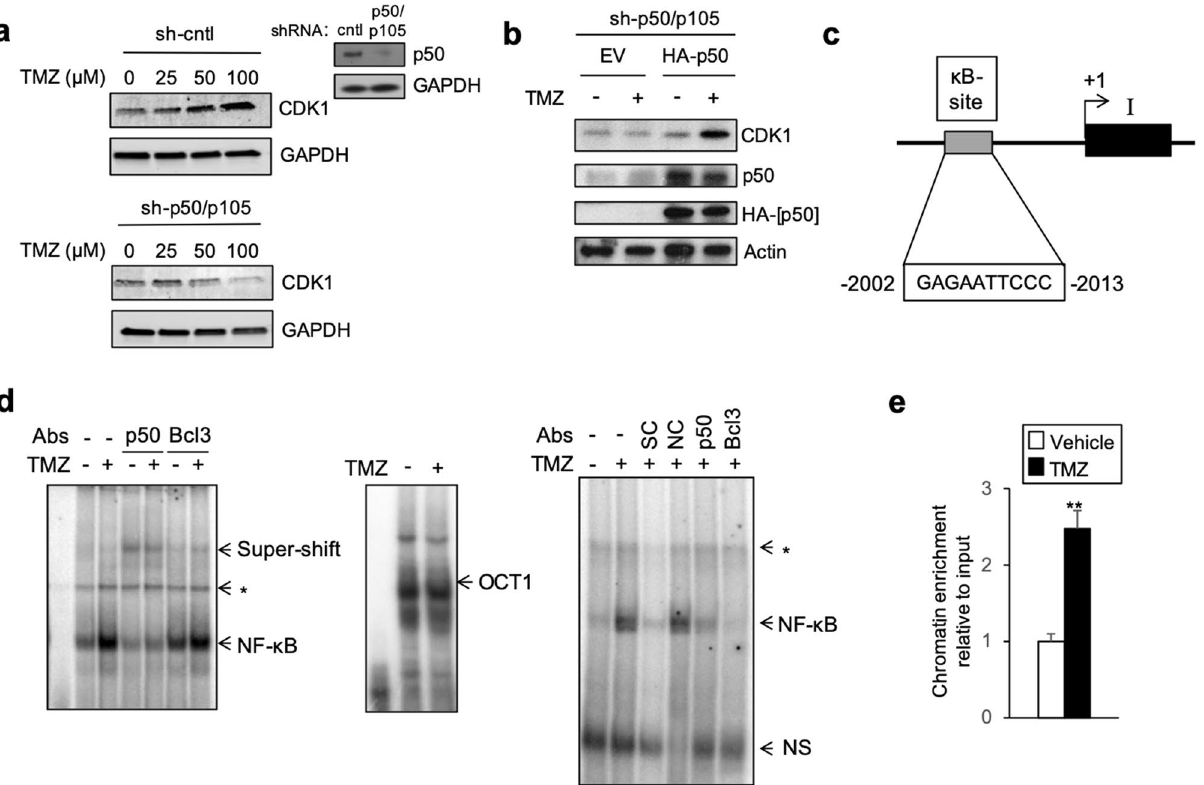
Figure 3. TMZ induces CDK1 expression in a p50-dependent manner and CDK1 contains a conserved κB-site that binds p50. ( a , b ) Immunoblt (IB) with the indicated antibody. ( a ) U87 cells stably expressing sh-control (cntl) or sh-p50/p105 treated with TMZ (24 h). ( b ) U87 cell stably expressing sh-p50/p105 transfected with HA-p50 or empty vector (EV) following treatment with TMZ (100 μM, 24 h). ( c ) Schematic representation of CDK1 promoter region. ( d ) EMSA with the CDK1 κB-site probe using nuclear extract from U87 cells treated with TMZ (100 μM, 24 h). Supershift was performed using anti-p50 and anti-BCL-3. NS represents non-specific band. OCT1 EMSA (middle panel) demonstrates equal loading. Competition EMSA (right panel) performed following incubation of κB-site probe with specific and non-specific competitors (SC and NC), respectively. *Represents band not shifted by either anti-p50 or anti-BCL-3. ( e ) qChIP in U87 cells treated with TMZ (100 μM, 24 h). Data represent mean chromatin enrichment using anti-p50 relative to input after controlling for nonspecific binding using anti-histone H1 (positive control) and anti-IgG, normalized to vehicle, ± SD of triplicate samples, repeated. IB data representative of duplicate experiments. ** P < sharing 86% homology with the canonical κB binding site was identified in the proximal promoter (Fig. 3c). To examine binding of NF-κB to this putative κB sequence, nuclear lysate from U87 cells was incubated with an